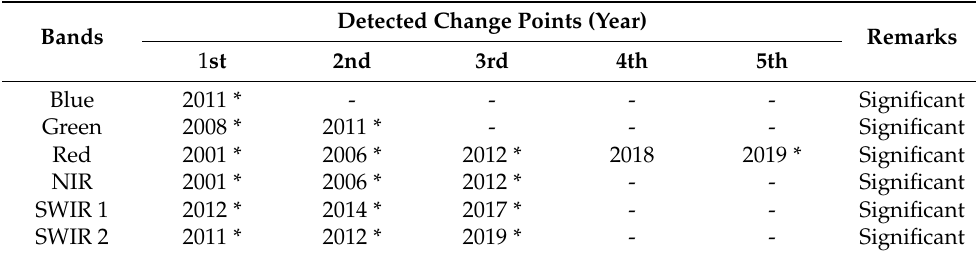
Figure 12. TOA reflectance data of the virtual constellation over Libya 1 for blue, green, red, NIR, SWIR 1, and SWIR 2 bands with fitted trend lines before and after turning points. Table 13. Change point detection by sequential versions of the Mann–Kendall tests for Libya